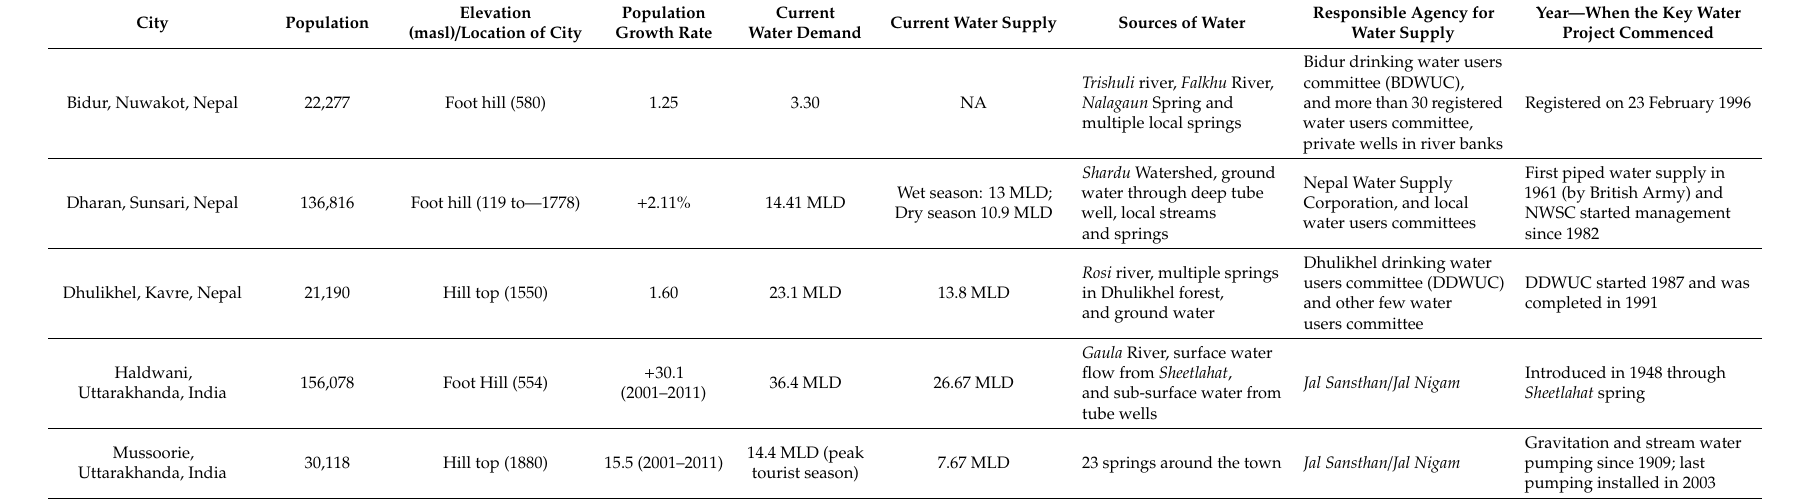
Table 1. Comparative overview of the five